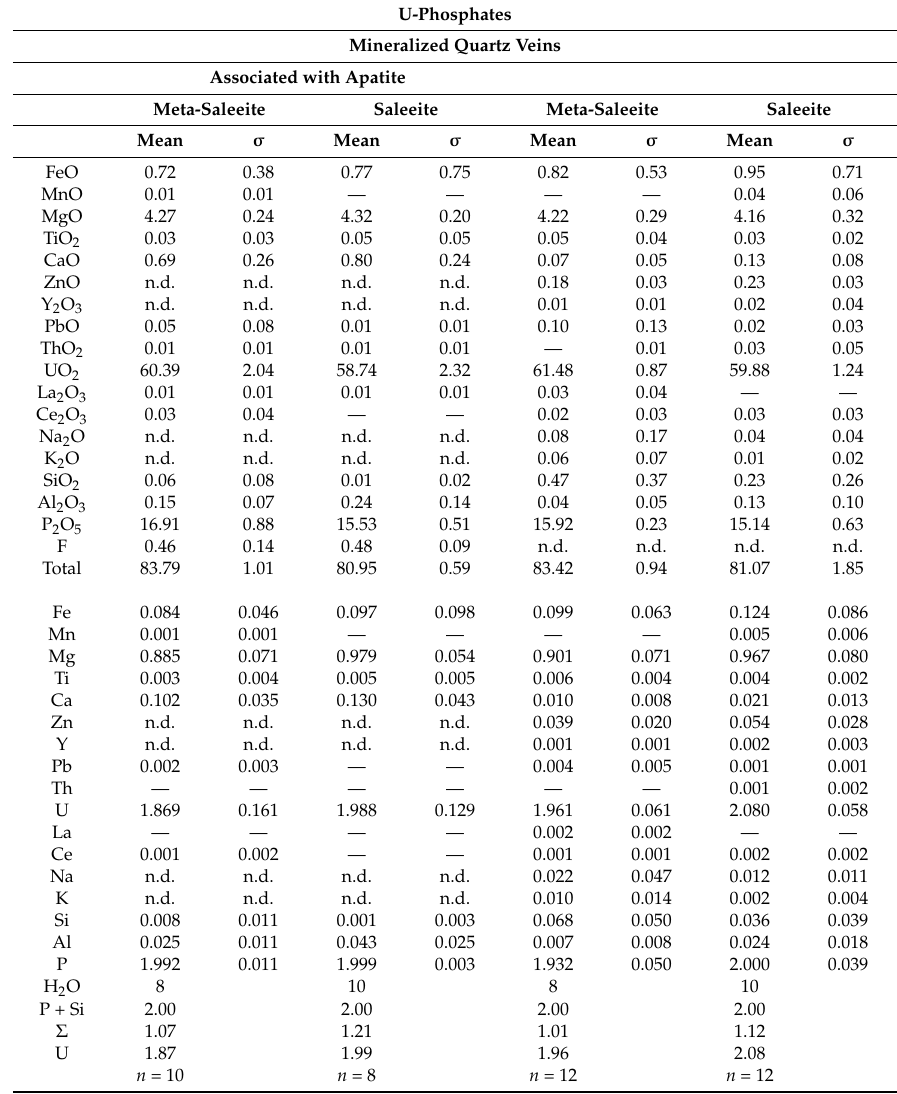
Table 4. Chemical composition (in weight percent) and structural formula of saleeite and meta-saleeite from the hydrothermal quartz veins, Central